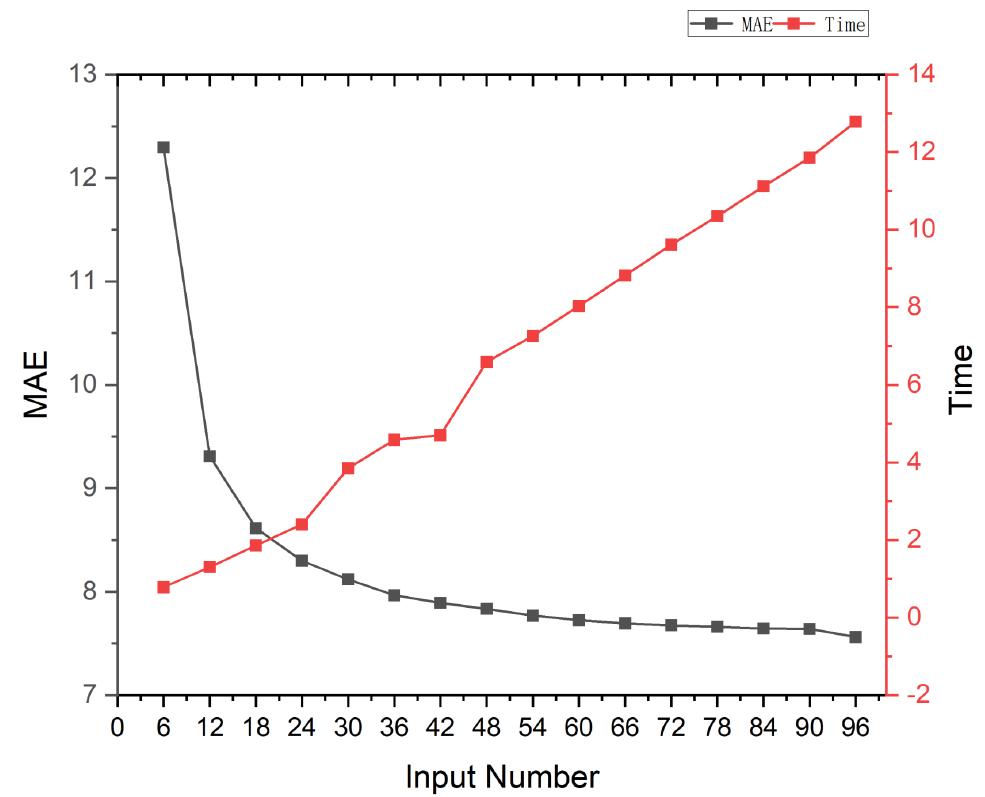
Figure 9. Performance and prediction time of MT-PS-CNN with the different number of inputs on the DiLiGenT dataset. The horizontal axis represents the number of inputs. The left vertical axis represents the mean angular error (MAE ◦ ). The right vertical axis represents the prediction time (s). Beginning with 96 inputs, we reduced the number of inputs by 6 at a time and calculated the average MAE over 10